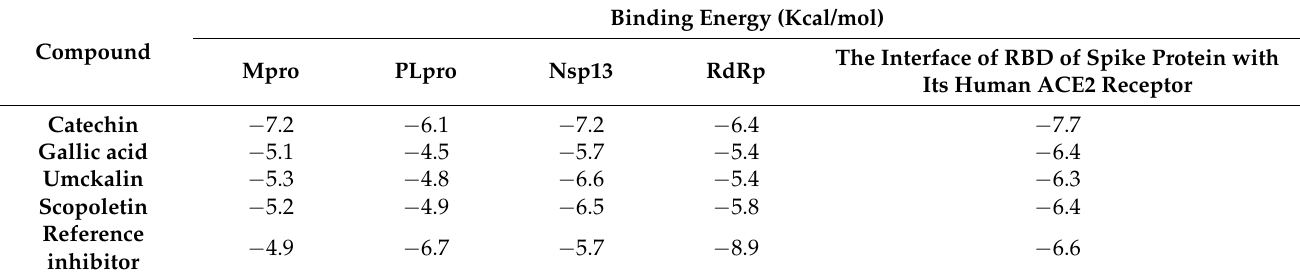
Table 4. Docking scores of Pelargonium sidoides biomolecules against the SARS-CoV-2 main therapeutic targets using AutoDock Vina in PyRx